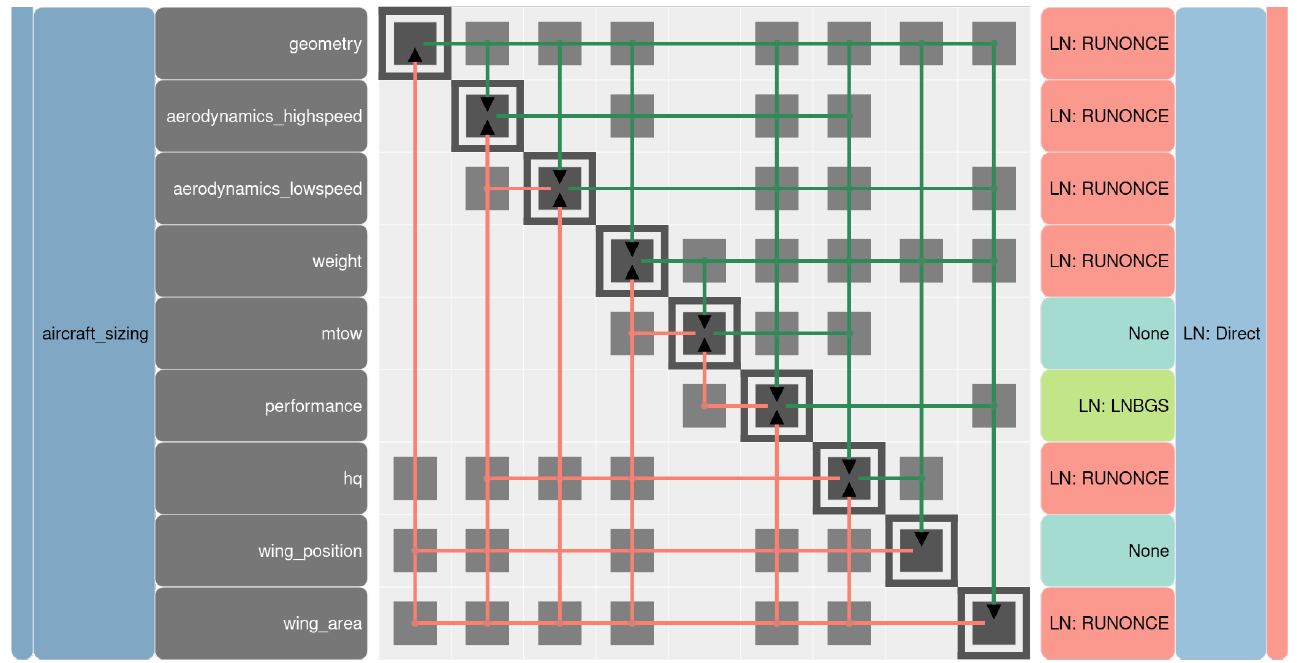
Figure 2. Representation of the typical FAST-OAD-GA process as an N2